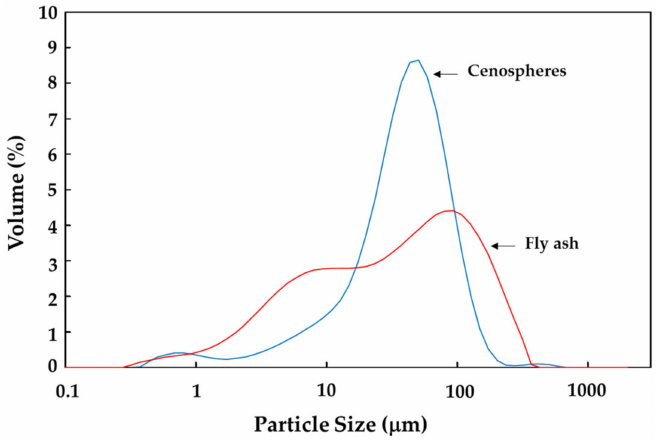
Figure 1. Particle size distribution profiles of fly ash and cenospheres collected by the sink-float method using 1:10 fly ash-to-medium ratio, 2 h soaking